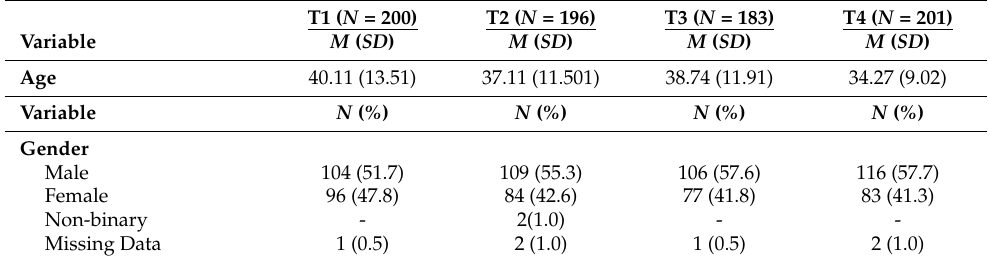
Table 1. Demographics Means, Standard Deviation, and